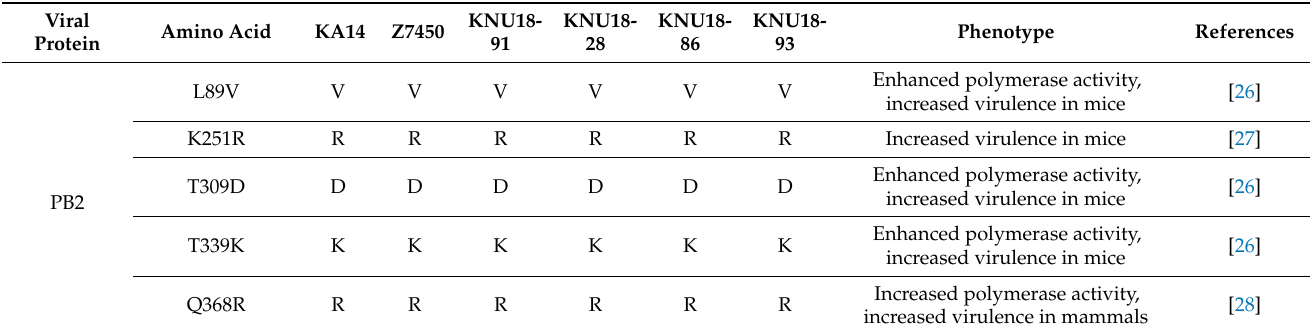
Table 5. Amino acid mutation analysis of eight gene segments responsible for enhancing polymerase activity, viral transmissibility, and virulence of the three novel H5N2